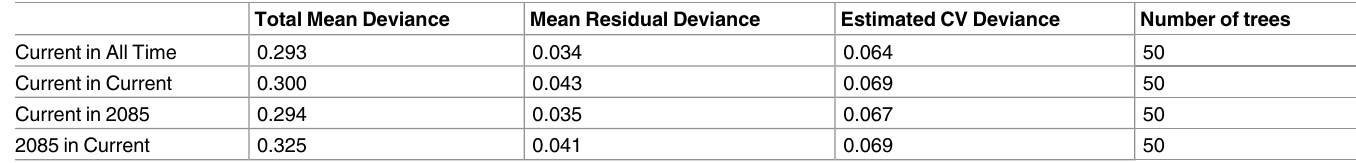
Table 2. The total mean deviance explained, mean residual deviance, estimated coefficient of variation (CV) of deviance, and the number of trees in each of the Boosted Regression Tree models. Total Mean